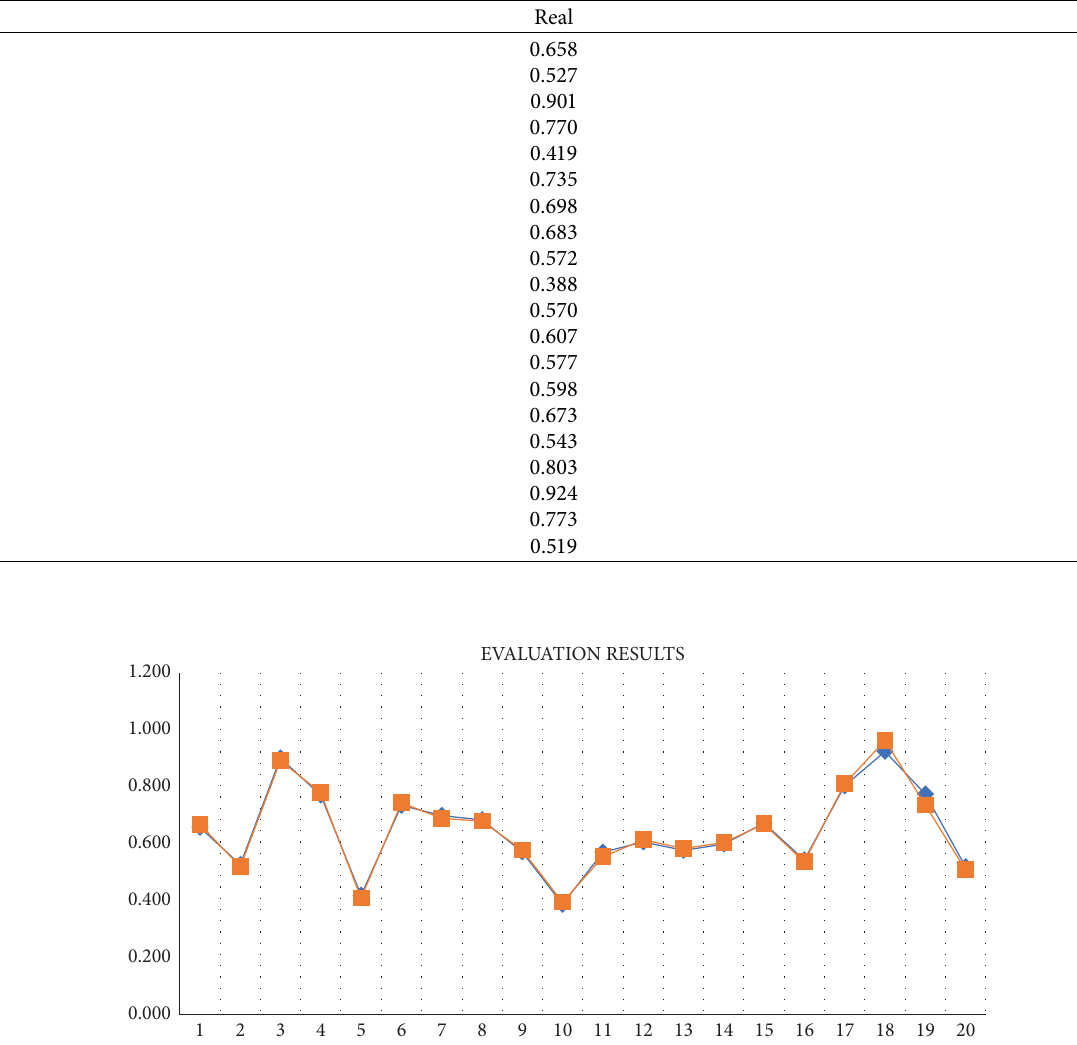
Table 7: Comparison of analysis results.